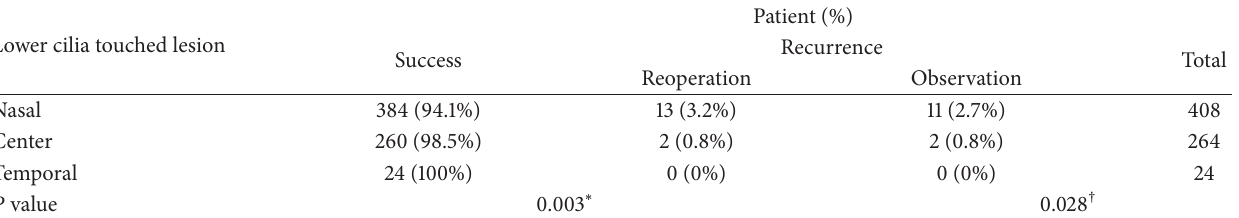
Table 5: Distribution of surgical outcome according to lower cilia touched